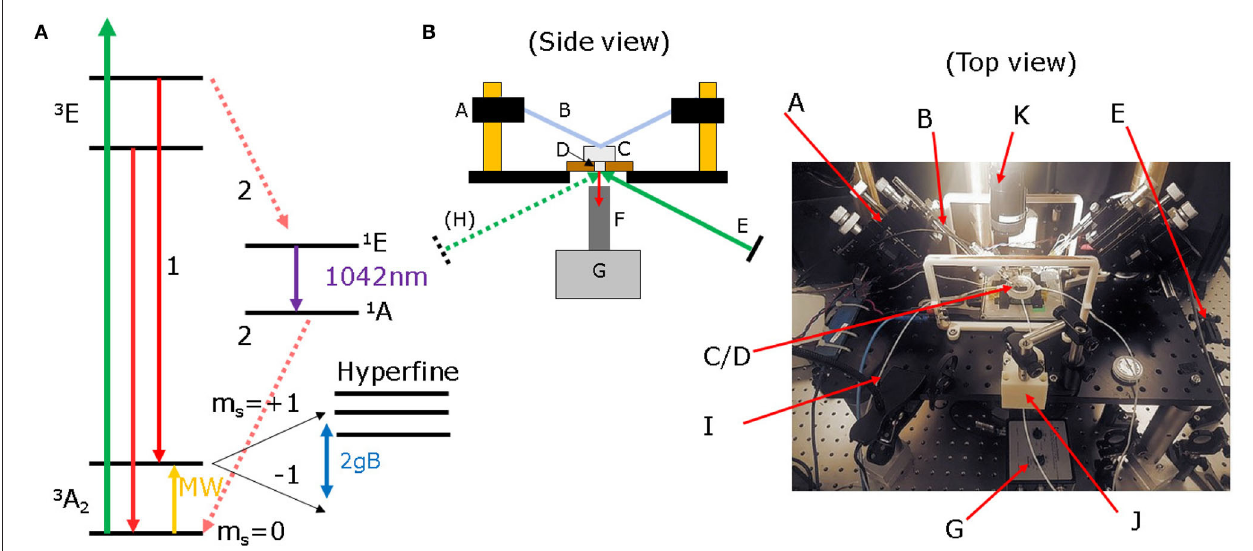
FIGURE 1 | (A) Simplified level structure of an NV − defect in diamond. Under 532 nm green laser illumination and on microwave resonance between the fine (and hyperfine) split levels, decay back to the 3 A 2 ground state can occur non-radiatively/via IR emission, resulting in magnetic field sensitive drop in red fluorescence. (B) Simplified schematic and photograph of our electrophysiology microscopy-style setup, with illumination and fluorescence collection under a raised platform, with access from above by contacting electrodes and a white light microscope. Key: (A) micromanipulators, (B) stimulation/readout electrodes, (C) sample chamber, (D) diamond (in AlN plate, on MW antenna board), (E) tilted mirror directing laser to sample, (F) collection lens/microscope objective, (G) photodetector, (H) optional tilted mirror for second laser (not shown in image), (I) solution feed tubing, (J) DC offset permanent magnets, (K) white light